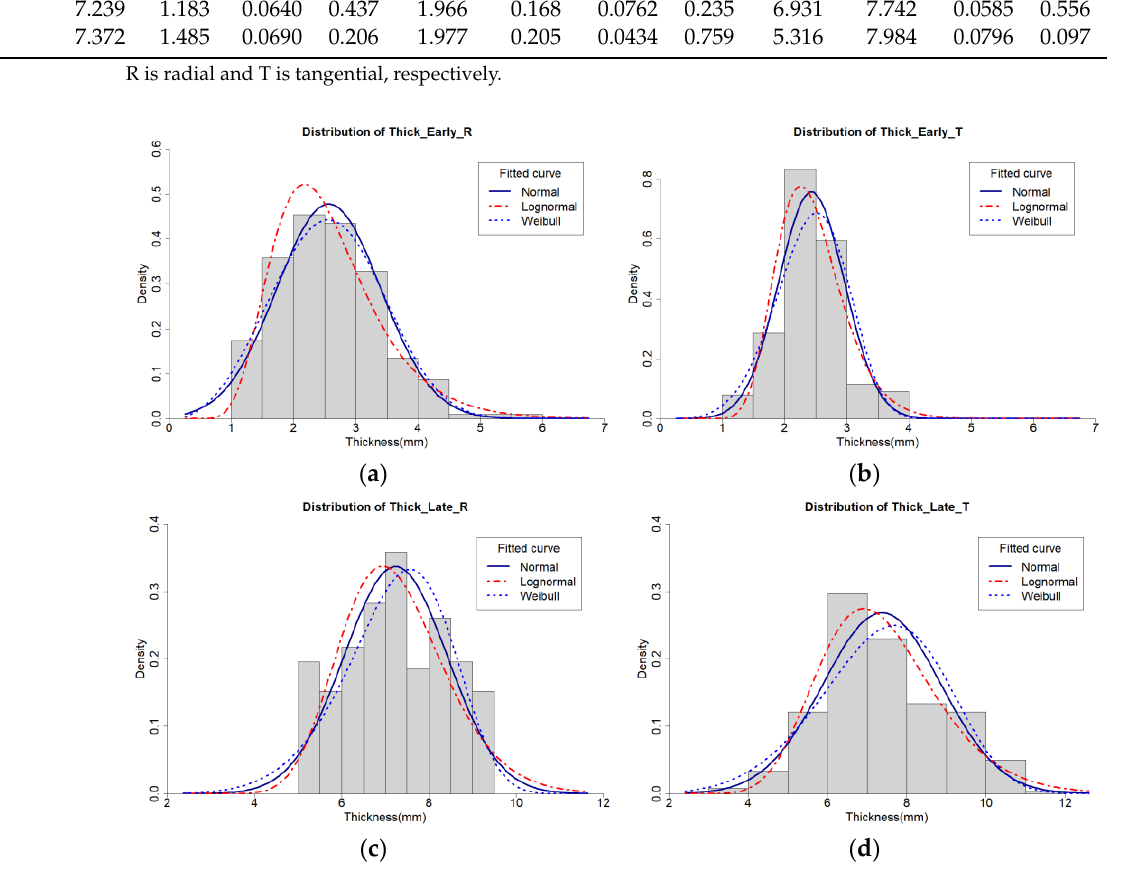
( b ) Figure 5. The mean and variance of yield force versus the number of simulations: ( a ) Mean of yield force; ( b ) Variance of yield force.